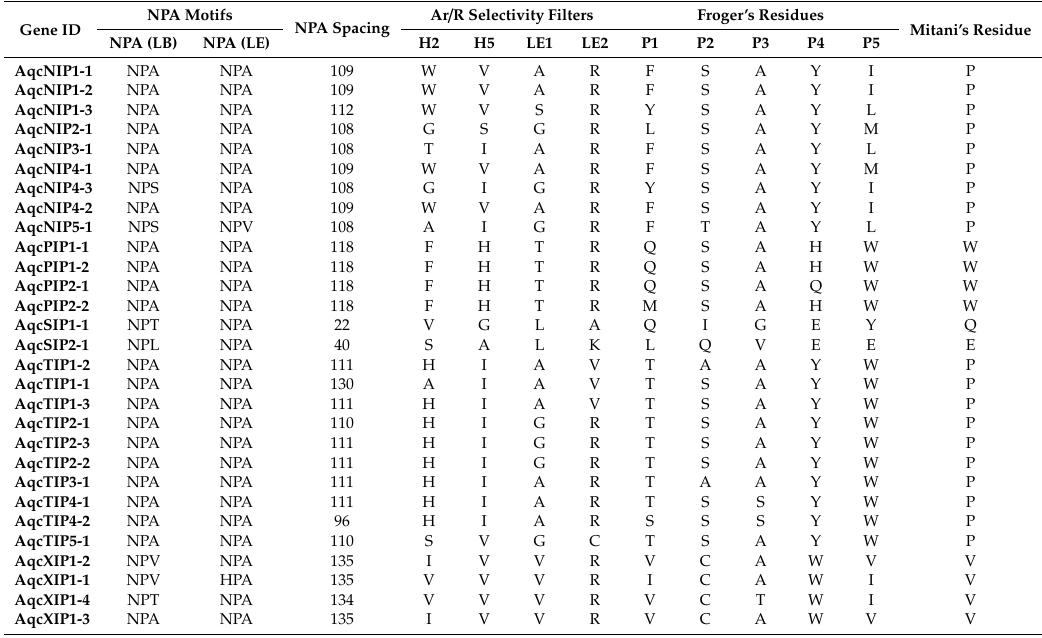
Table 1. Details of conserved domains, selectivity filter, and amino acid residues of aquaporins identified in the Aquilegia